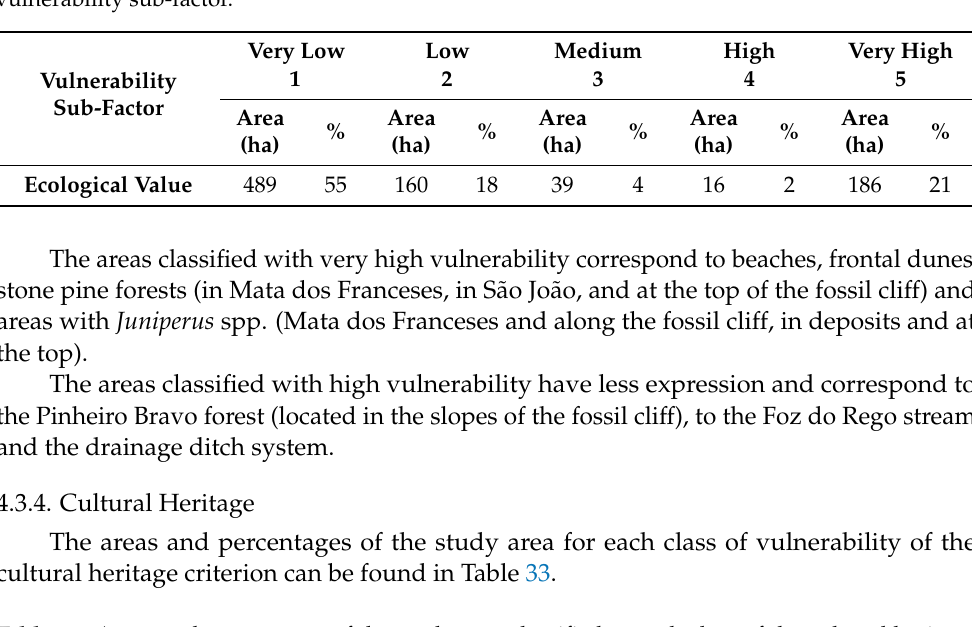
Table 33. Areas and percentages of the study area classified as each class of the cultural heritage vulnerability